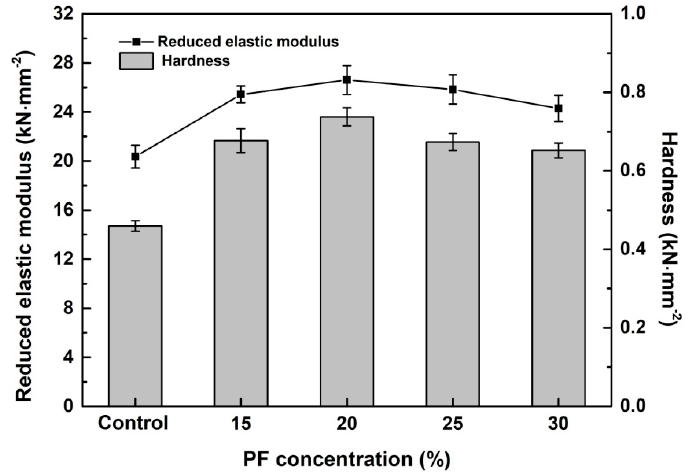
Figure 7. The reduced elastic modulus and hardness of the control and modified wood cell walls.